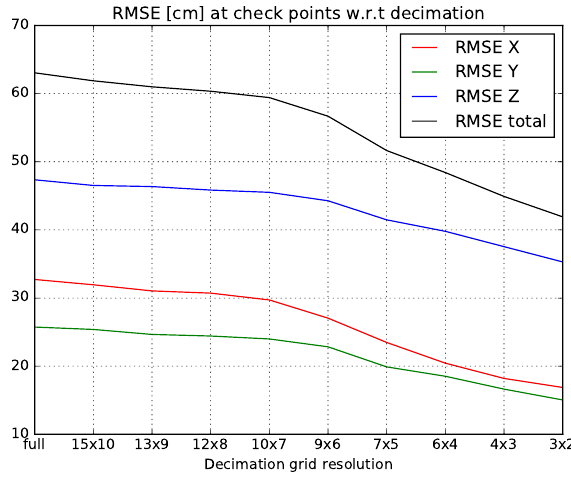
Figure 4: RMSE at check points for different decimation grid